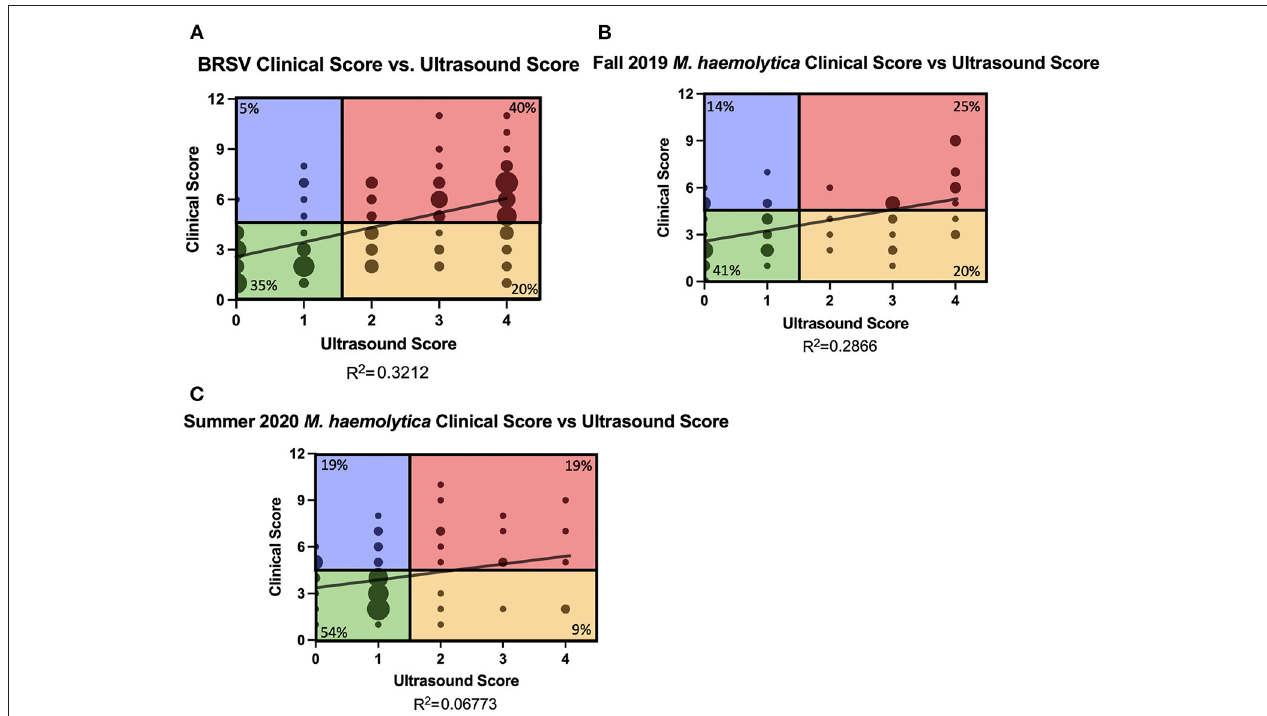
FIGURE 4 | Relationship of clinical score and TUS score and classification of calves. Daily clinical scores were compared to daily ultrasound scores from BRSV-infected calves (A) and M. haemolytica –infected calves (B,C) . The graphs include all data points from days 0, 3, 7, 10, and 14 in BRSV-infected calves and from days 0 to 4 in M. haemolytica –infected calves. The size of the point represents the number of calves represented in each location: (A) the maximum dot size represents 10 calves; (B) the maximum size dot represents seven calves; (C) the maximum sized dot represents 12 calves. The plots were divided into four quadrants according to positive clinical score ( ≥ 5) and positive ultrasound score ( ≥ 2). Green quadrant represents calves that are negative for clinical score and ultrasound score. Blue quadrant represents calves with positive clinical scores but negative ultrasound scores. Red quadrant represents calves with elevated clinical and ultrasound scores (clinical). Yellow quadrant represents calves who had non-elevated clinical scores but had positive ultrasound scores (subclinical). The percentage in each quadrant represents the frequency of points from that study represented in each